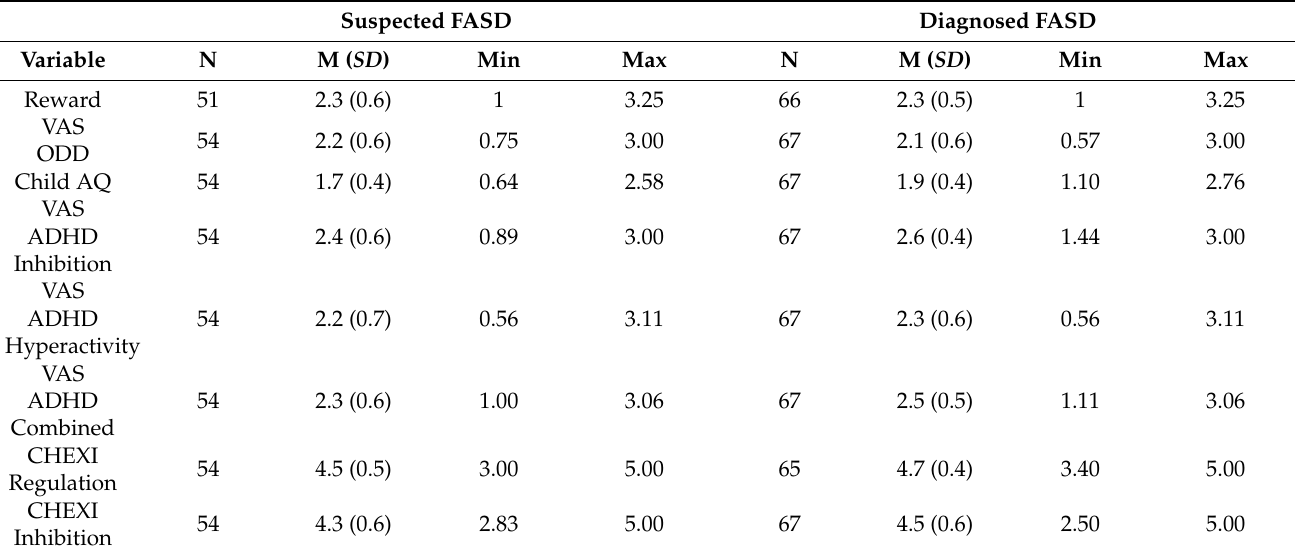
Table 1. Descriptive statistics showing the ratings of the Suspected FASD and Diagnosed FASD groups across the various